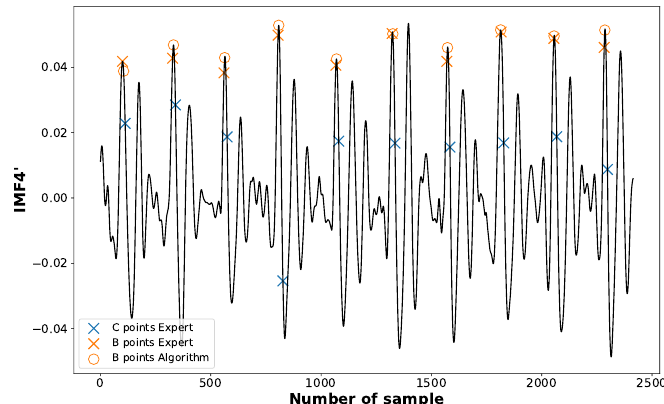
Figure 7. The positions of B points marked according to an expert (crosses “ × ”) and identified by the proposed algorithm (circles